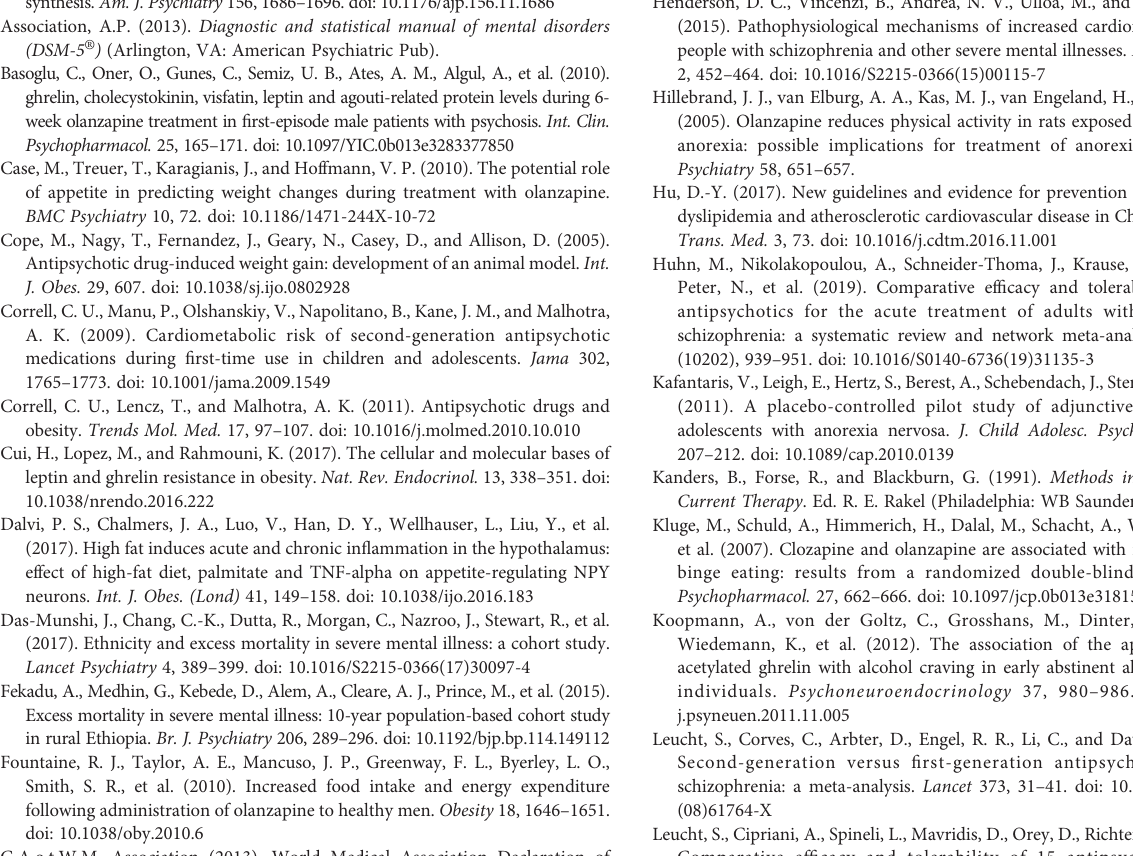
SUPPLEMENT TABLE 4 | Comparison of numbers of 7% or 10% weight gain between patients with increased appetite and patients with unchanged appetite at weeks 4, 8, and 12.